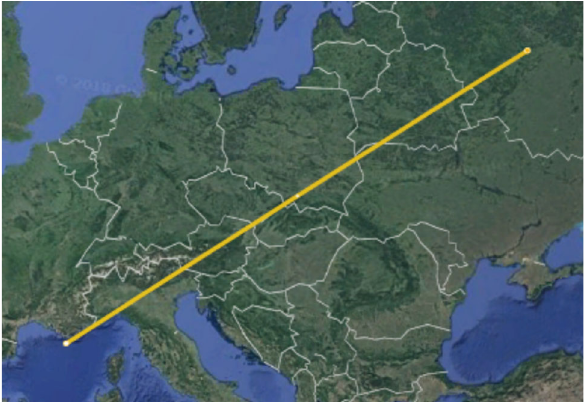
Fig. 3 Path to be traveled by the neutrino beam from Protvino (in the top right) to ORCA (in the bottom left). The path length is ≈ 2595 km and the deepest point is 135 km below sea level, in the upper mantle